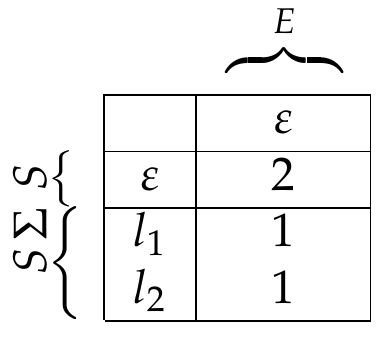
– First Iteration ∗